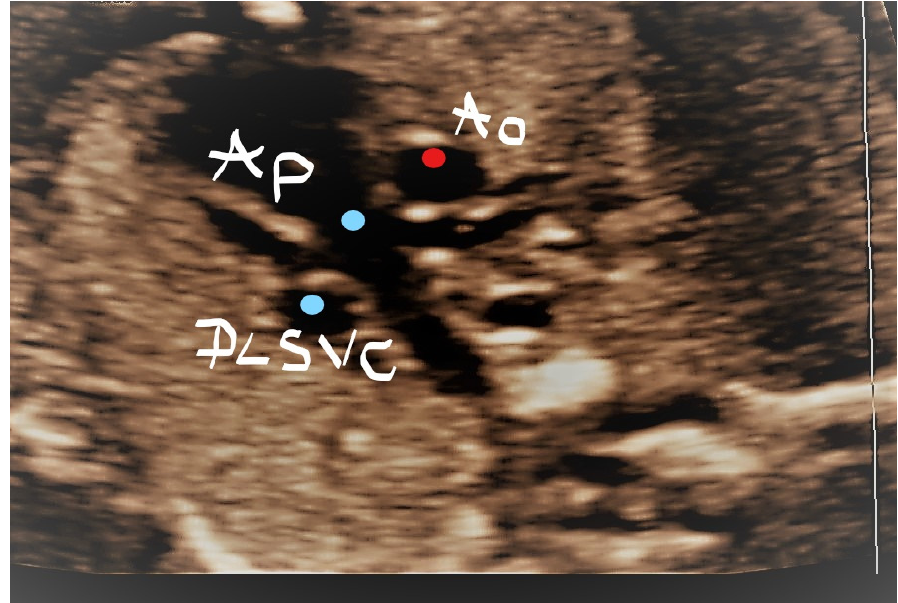
Figure 5. Transversal section at the TTVV level; absence of the right SVC. PLSVC—persistent left superior vena cava; Ao—Aorta; Ap—Pulmonary